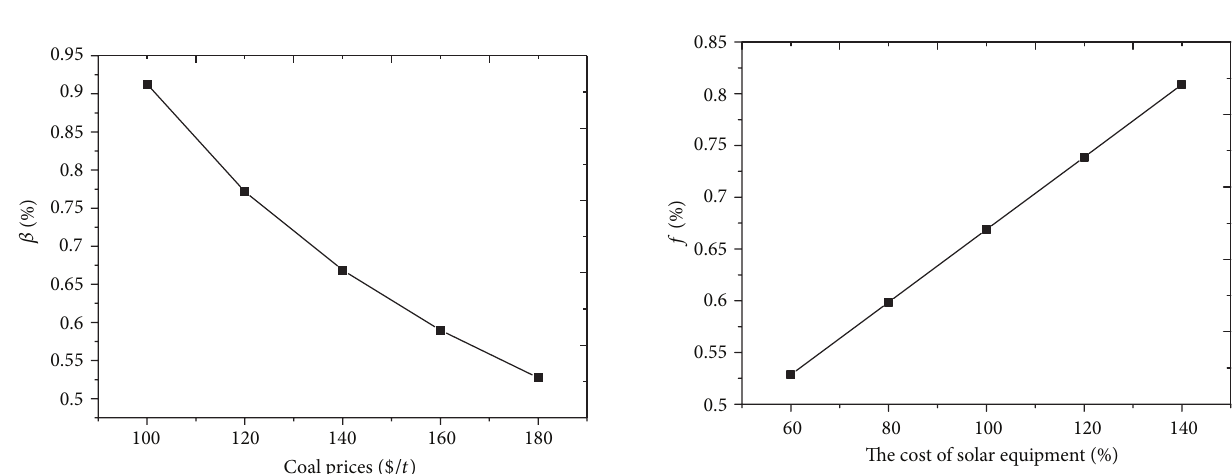
Figure 6: The change of the overall cost proportion of solar with coal cost.